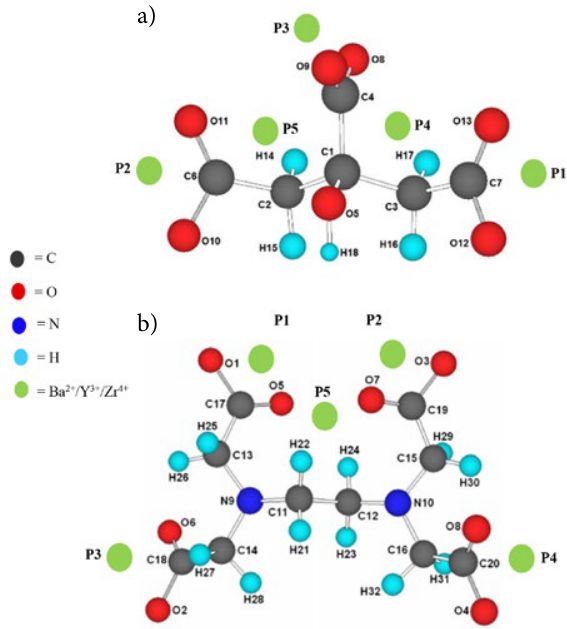
Fig. 1. Molecular structure of (a) CA attachment (Ba 2+ , Y 3+ , Zr 4+ ) at different positions (P1 to P5). Metal cations are green and C, O, N, and H are colored grey, red, blue, and turquoise,